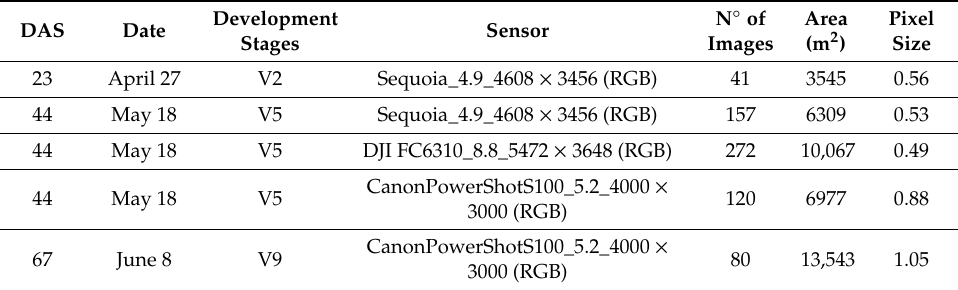
Table 1. Flight log at di ff erent days after sowing